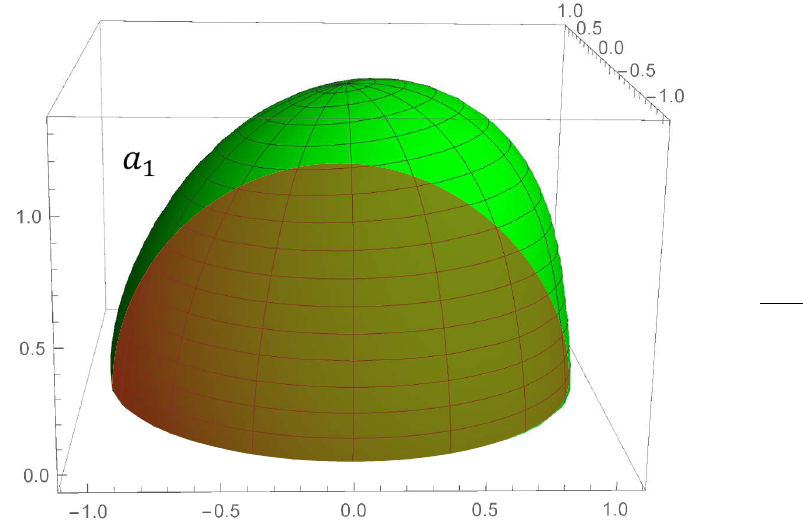
Figure 10 . The profile of the causal shadow in terms of the causal horizon (red) against the Q.E.S (green) in AdS , with ∆ = 2 . Again for illustration purpose we exaggerated the value of G 4 be order